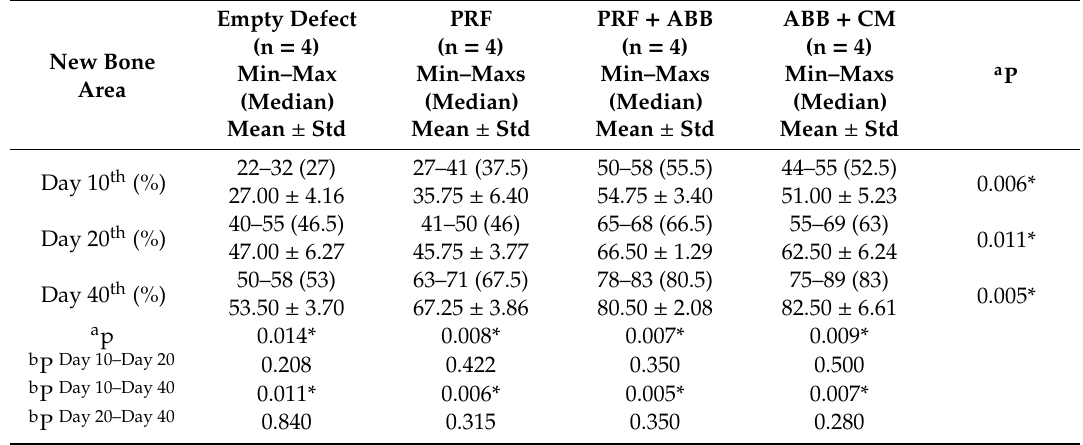
Table 1. Bone regeneration ratios in each group on day 10, 20, and 40.